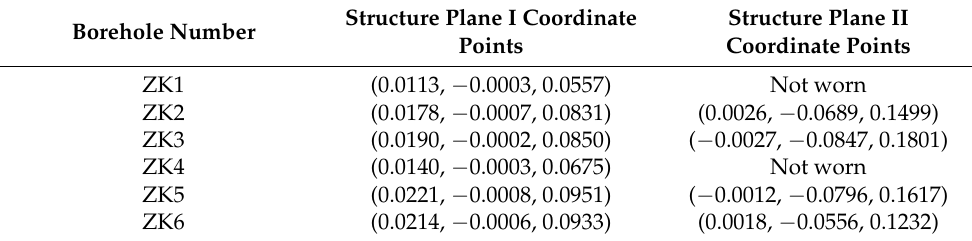
Table 4. Structural plane coordinate points in sample